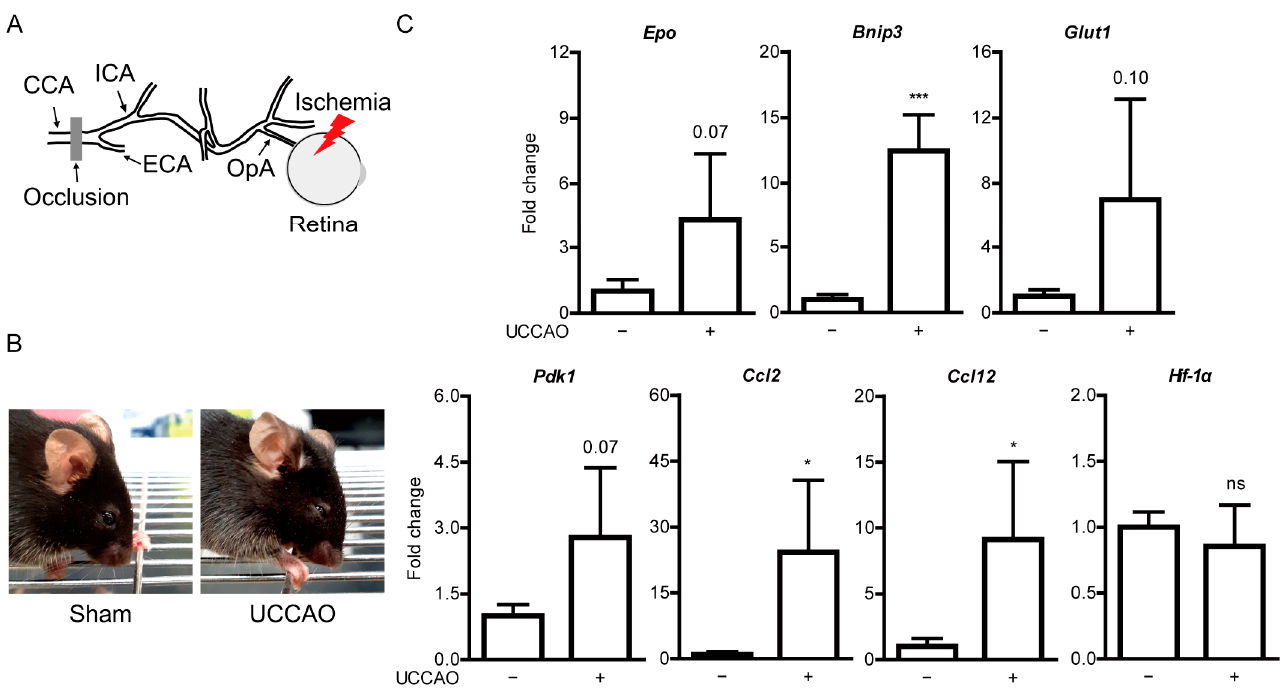
Figure 1. General features of ocular ischemia induced by unilateral common carotid artery occlusion (UCCAO) in adult mice. ( A ) Schematic illustration of induction of ocular ischemia by UCCAO. Ocular ischemia (a red thunder) can be induced by occlusion (a gray bar) of the common carotid artery (CCA) in that the ophthalmic artery (OpA) is originated from the internal carotid artery (ICA) of CCA. ( B ) Representative images show eyelid drooping in the eye 1 day after UCCAO. ( C ) Quantitative analyses ( n = 4 per group) show increases in Bnip3 , Ccl2, and Ccl12 mRNA expressions in the UCCAO-operated retina 1 day after UCCAO, in comparison with those in the sham-operated retina. * p < 0.05, *** p < 0.001. The data were analyzed using Student’s t-test (two-tailed) and presented as mean ± standard deviation.